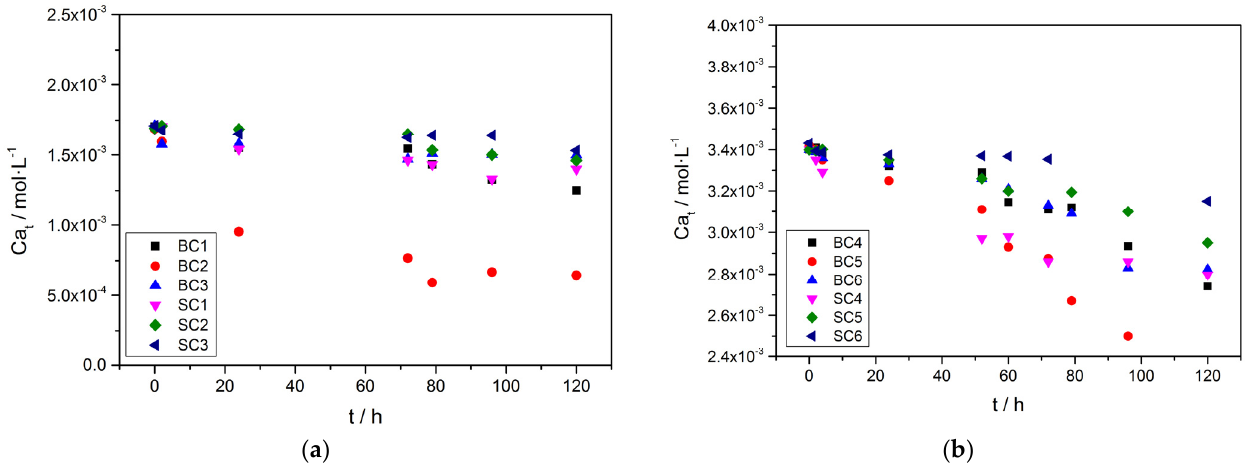
Figure 4. Calcium concentration as a function of time during the precipitation of calcium carbonate in the presence of A. obliquus culture and nutrient medium under illumination, in the presence of Zn; ( a ) Ca t = C t = 1.7 mM; ( b ) Ca t = C t = 3.4 mM; 25 °C, pH initia 8.50, 0.15 Μ of NaCl. ( a ) Ca t = C t = 1.7 mM; ( b ) Ca t = C t = 3.4 mM; 25 ◦ C, pH initia 8.50, 0.15 M of